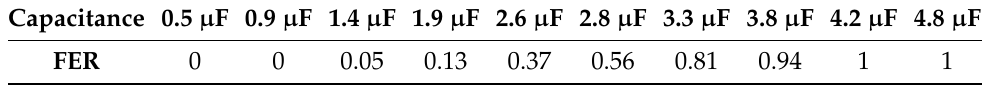
Table 2. FER vs. the capacitance located near the measuring point.